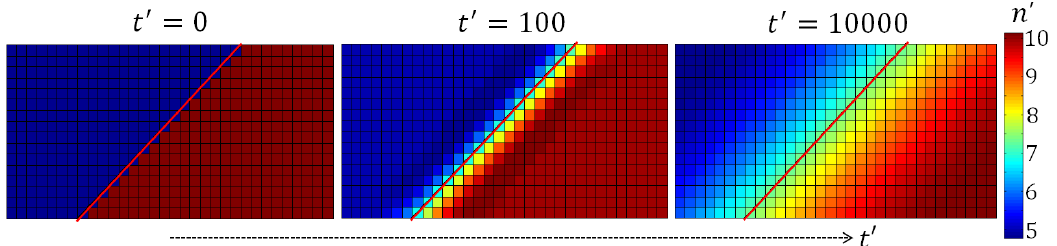
Figure 5. Time evolution for a simple diffusion problem on a Cartesian mesh for the case Θ = D (cid:107) / D ⊥ and α = − 45 ◦ . Non-dimensionalized variables are